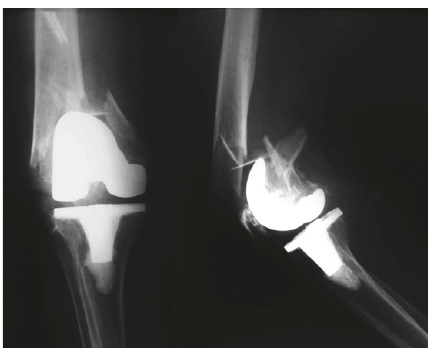
Figure 1: Presenting knee injury X-rays. Note the severe comminu- tion of the metaphyseal area, including the medial wall of the distal femur. Radiologically, the femoral component seemed to be